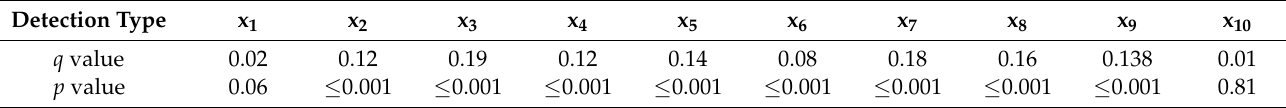
Table 3. q -values of land use changes in open-pit coal